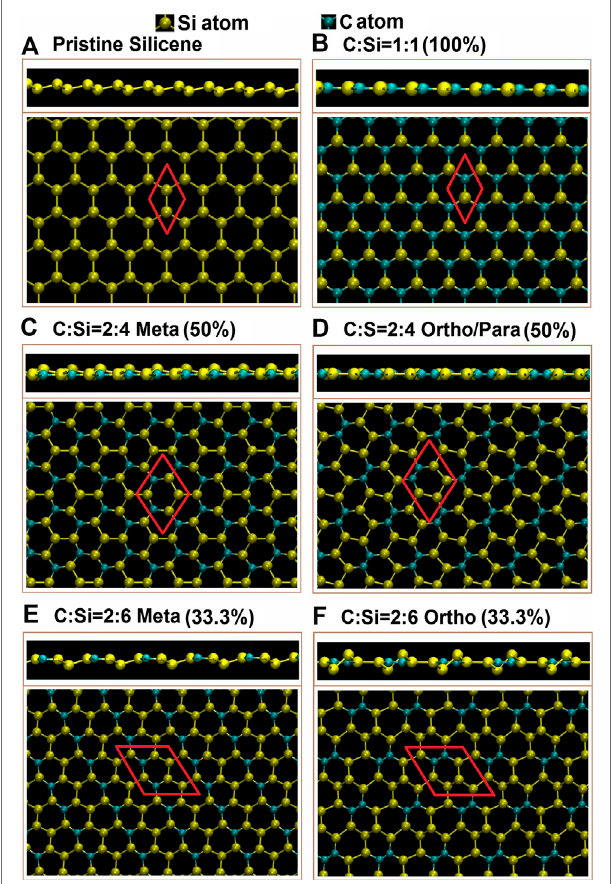
FIGURE 1 | The top and side views optimal geometric structures for C-substituted silicene systems; the (A) pristine, (B) full-, (C) 50%-meta-, (D) 50%-ortho-/para-, (E) 33.3%-meta, (F) 33%-ortho, (G) 3.3%-para-, (H) 12.5%-meta-, (I) 12.5%-ortho-, (J) 12.5%-para-, (K) 14.3%-single-, and (L) 5.8%-single-substitution cases. Also the red parallelogram/rhombus represent the unit cell.